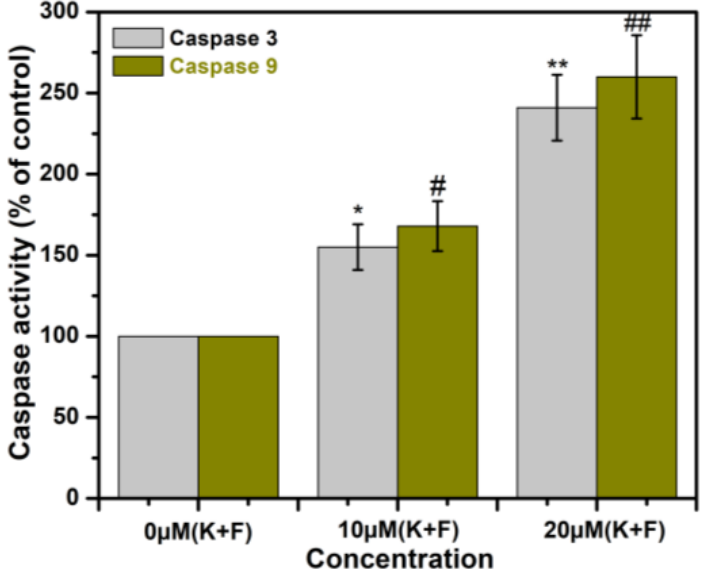
Figure 7. The level of active caspase-3 and caspase-9 after 10 and 20 μM (K + F) treatments for 24 h. * and # has been used to compare the caspase-3 and caspase-9 activity with control. Statistical significance: */# p < 0.05, **/## p < 0.01